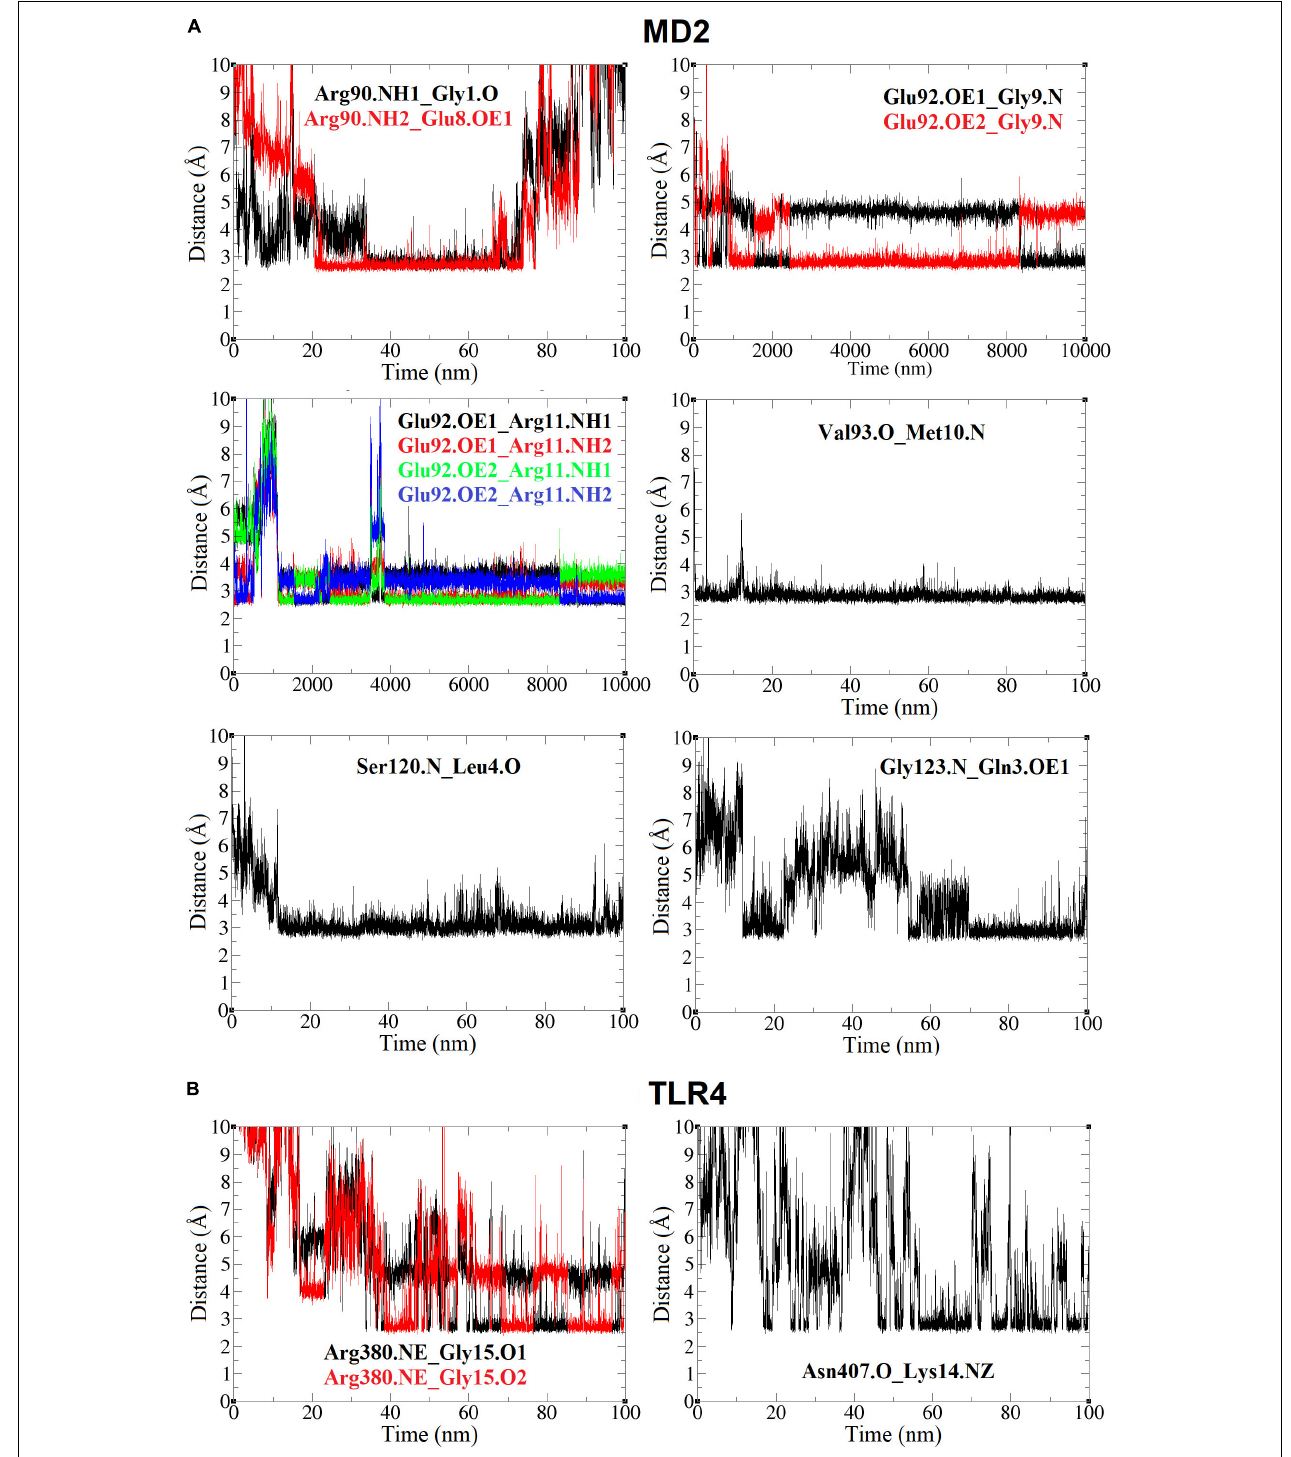
FIGURE 7 | Distance (Å, Y axis) vs. time (nm, X axis) plots between TLR4/MD2 and Peptide-2 residues, for the TLR4/MD2/Peptide-2 complex simulated by MD at 310 K for 100 ns. (A) Plots (yellow box) for MD2 residues. (B) Plots (blue box) for TLR4 residues. In all notations, the left residue belongs to the TLR4 or MD2 subunit and the residue at right is from Peptide-2. Single O or N: residue backbone atoms. NH1, NH2: nitrogen atoms at the end of the arginine side chain. NE: nitrogen epsilon atom of arginine side chain. NZ: nitrogen atom of lysine side chain. O1, O2: glycine 1 oxygen atoms at the C-terminus of Peptide-2. OE1, OE2: oxygen atoms of glutamic acid side